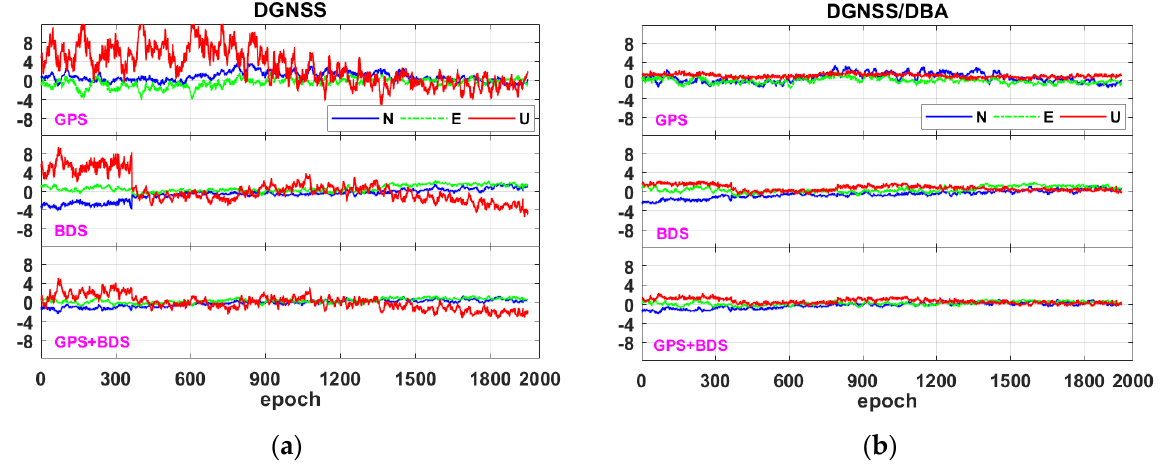
Figure 7. The deviation sequence diagram in the N/E/U directions at 30 − degree elevation mask an-